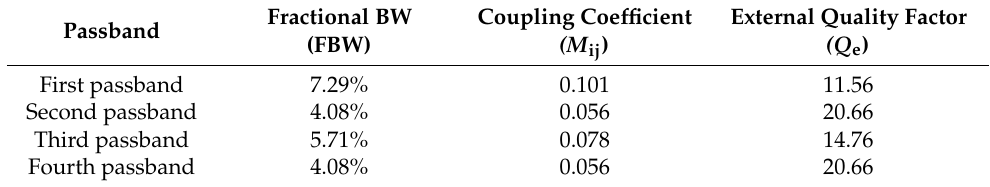
Table 1. The specifications of the proposed quad-band BPF.